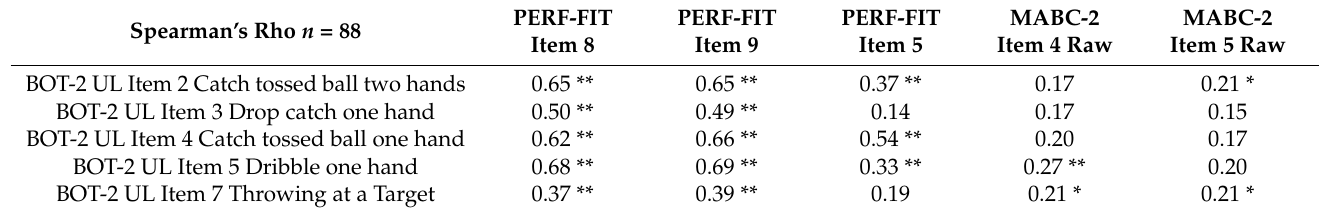
Table 4. Spearman correlation of BOT upper-limb coordination subtest items with PERF-FIT and